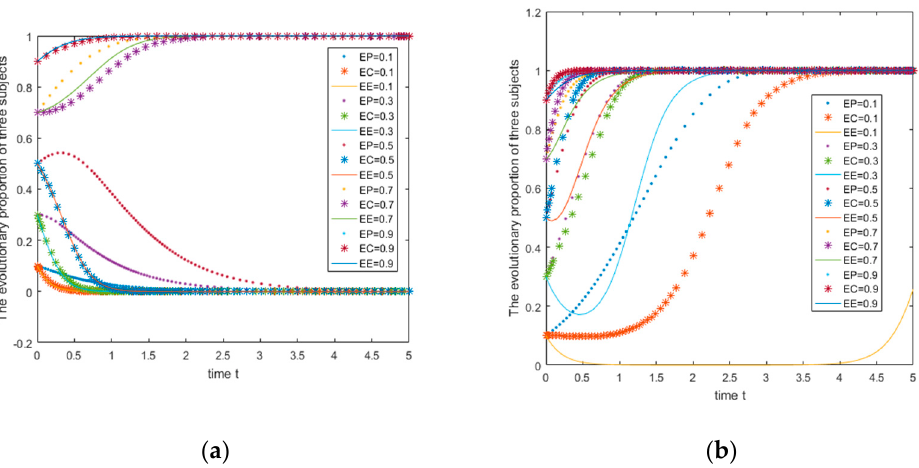
Figure 5. Different strategies correspond to the evolution graph under different basic income sce ‐ narios.